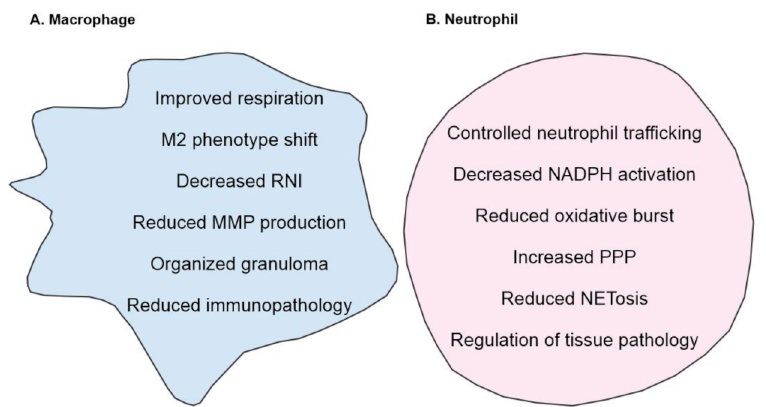
Figure 2. Overview of HO-1 mediated regulation of ( A ) macrophages, ( B ) neutrophils. ( A ) HO-1 improves mitochondrial respiration which in turn can modulate macrophage phenotype towards M2 phenotype. In addition, increase in HO-1 levels correlates with decreased MMP and RNI levels. ( B ) In neutrophils, HO-1 controls oxidative burst, decreases NADPH activation and shifts the neutrophil metabolism towards PPP. In addition, HO-1 also reduced the formation of NETosis and regulates neutrophil trafficking and recruitment. Together, these responses result in decreased inflammation and tissue